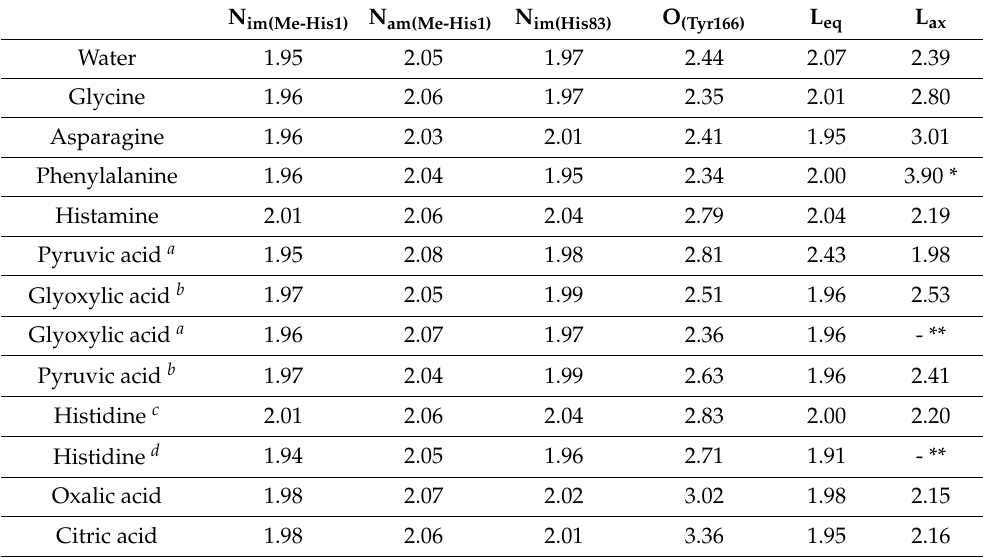
Table 5. DFT/B3LYP/6-31G(d)-optimized Cu(II)–L bond lengths in